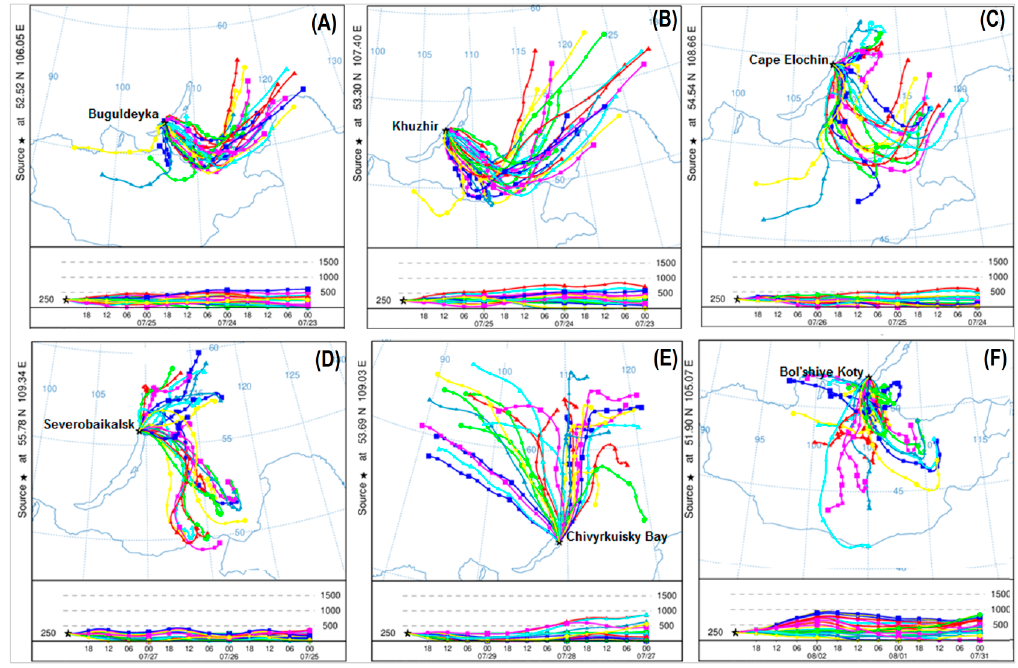
Figure 3. The air mass backward trajectories to Lake Baikal in July–August 2019: ( A ) 25 July, ( B ) 26 July, ( C ) 27 July, ( D ) 28 July, ( E ) 30 July, ( F ) 1 August [29].